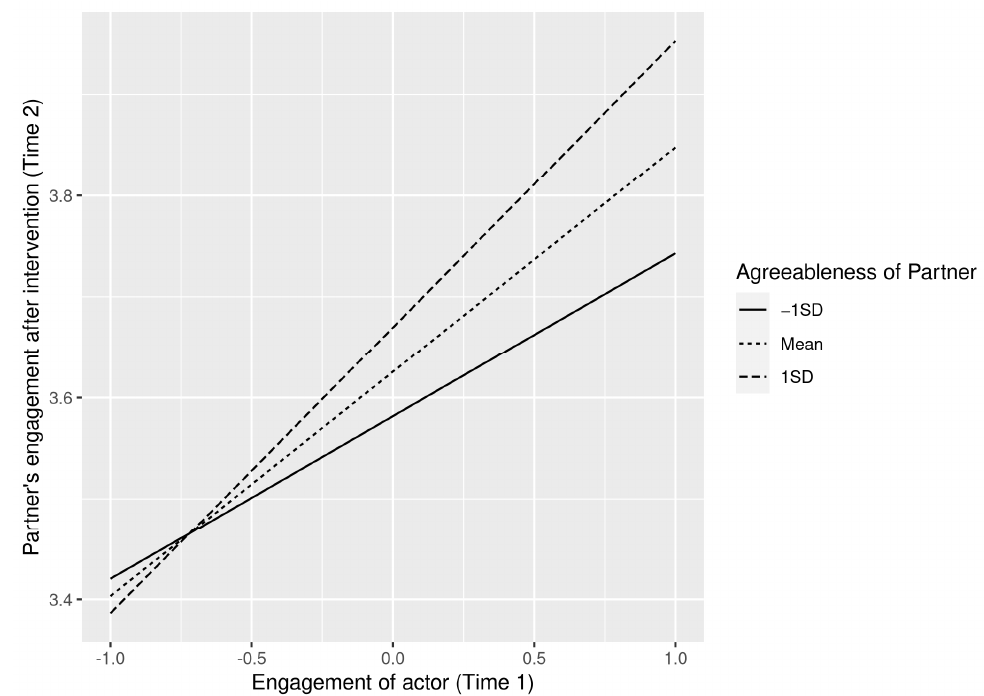
Figure 2. Interaction effect between an actors’ engagement and their partner’s agreeableness on the partners’ engagement.